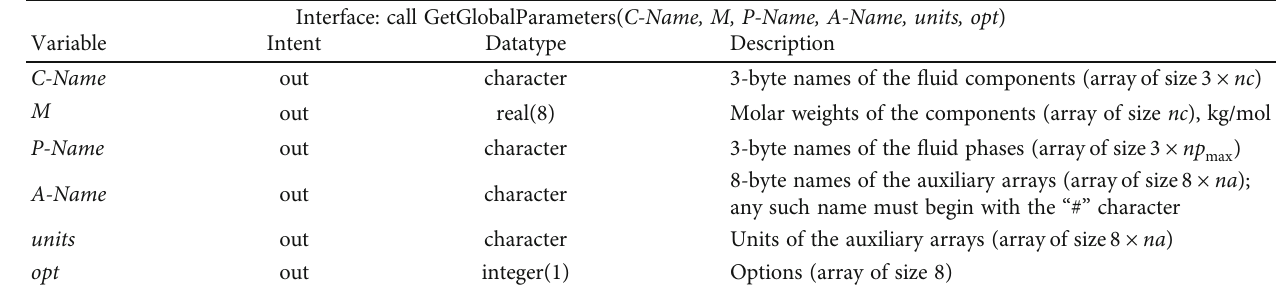
Table 3: API for GetGlobalParameters .